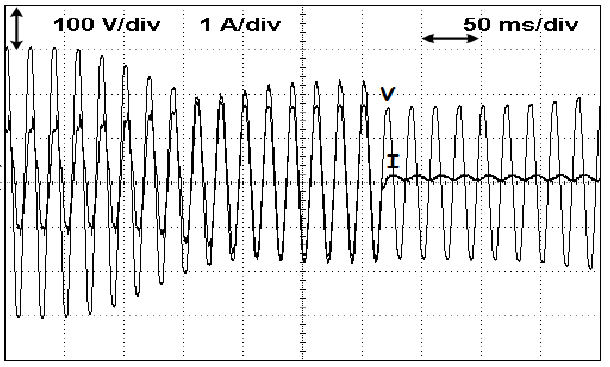
Figure 11. Three-phase PV inverter with four legs developed in the ambit of a European Project. The first tests with this three-phase PV inverter were performed for grid-balanced conditions. In accordance with the performed tests, the three-phase power supplied from the PV inverter to the grid (testing system) is balanced. The three-phase voltages that the testing system imposes on the PV inverter are presented in Figure 12a. On the other hand, the three-phase currents of the PV inverter are shown in Figure 12b. From those obtained results, it is possible to see that the voltages imposed by the testing system and currents injected by the PV inverter are balanced. The THD of the currents is also low, with a value of 4.3%. Another important parameter is the power factor that presents a very high value of 0.99 (in this test, the PV inverter was set to only inject active power to the grid). This high power factor can also be confirmed by the result shown in Figure 12c, in which the voltage and current in phase L 1 of the testing system are presented.